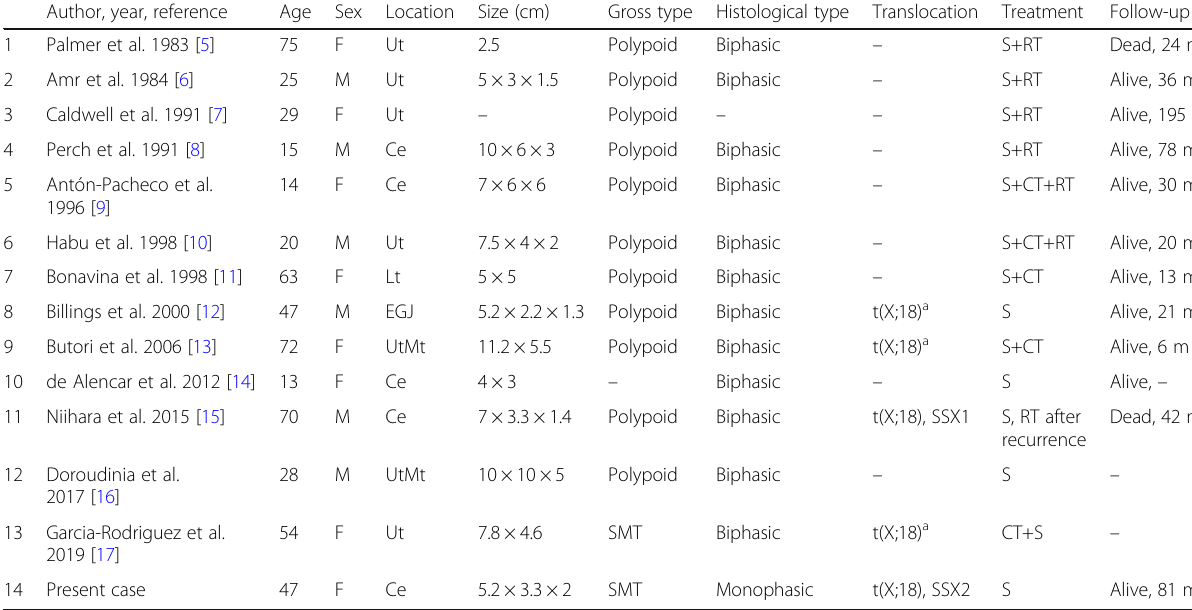
Table 1 A summary of the reported cases of primary synovial sarcoma of the esophagus Author, year,